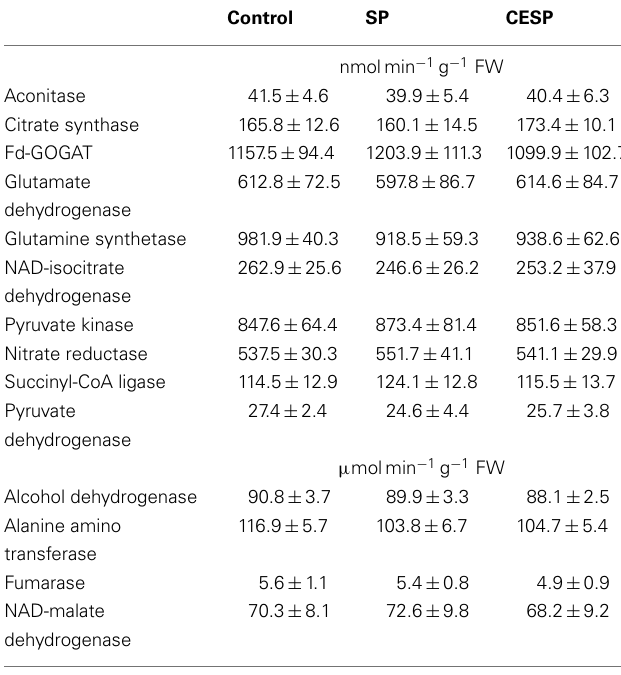
Table 1 |Assays of the key enzymes related to theTCA cycle in the absence (Control) and presence of 100 μ M of SP or